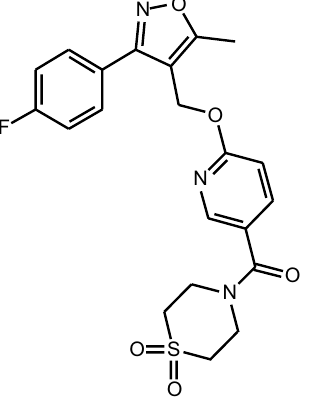
Figure 1. Chemical structure of basmisanil: RO5186582; RG1662; C21H20FN3O5S; molecular weight 445.469; 1,1-Dioxo-1,6-thiomorpholin-4-yl)-{6-[3-(4-fluoro-phenyl)-5-methyl-isoxazol-4-ylmethoxy]-pyridin-3-yl}-